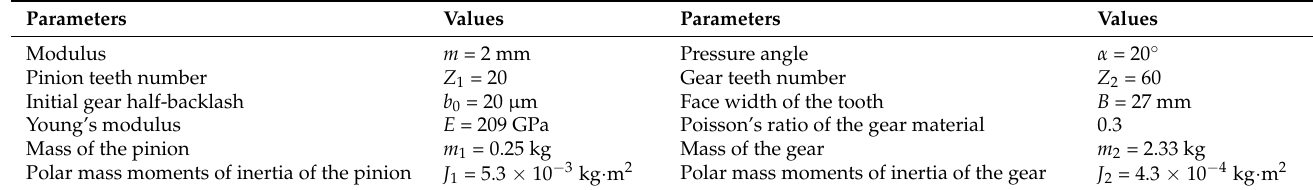
Table 1. Basic parameters of the gear